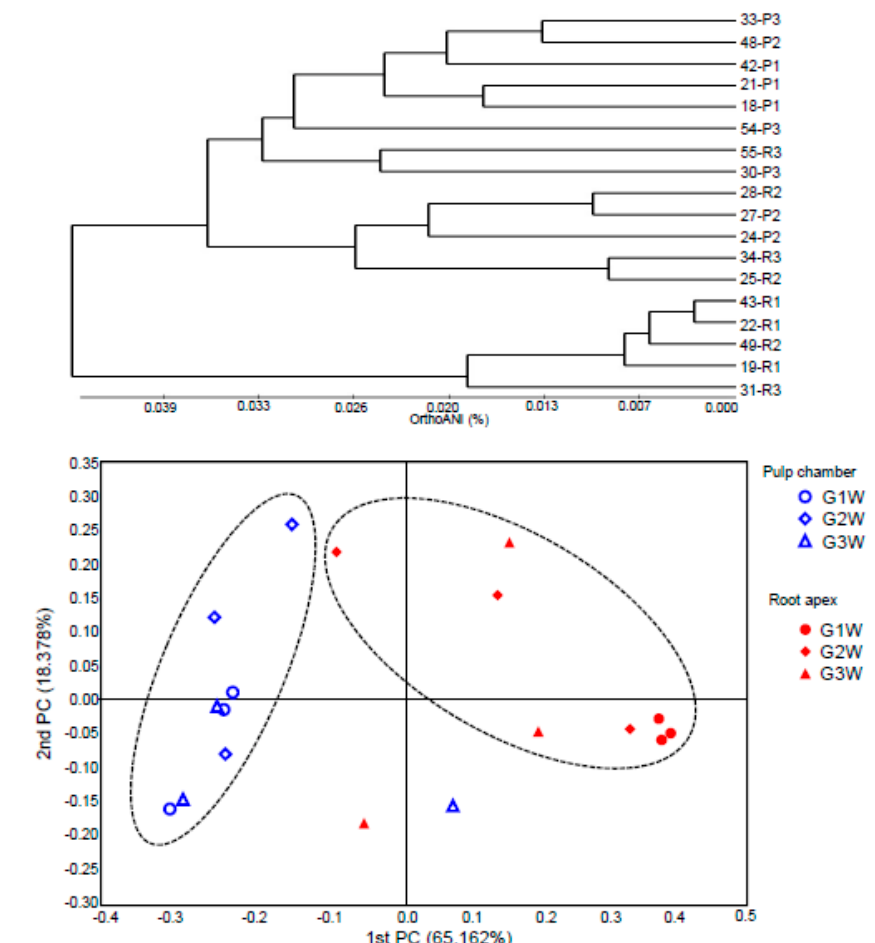
Figure 6. Principal coordinates analysis (PCoA) of the 18 bacterial communities at the species-level based on the microbiota. The beta-diversity distances were calculated using Fast UniFrac. ( A ) unweighted pair group method with arithmetic mean (UPGMA) dendrogram showing the relationship between 18 individual samples from the pulp chamber and root apex. ( B ) PCoA of UniFrac distances on 18 individual samples. Circles of the dashed lines indicate the cluster.